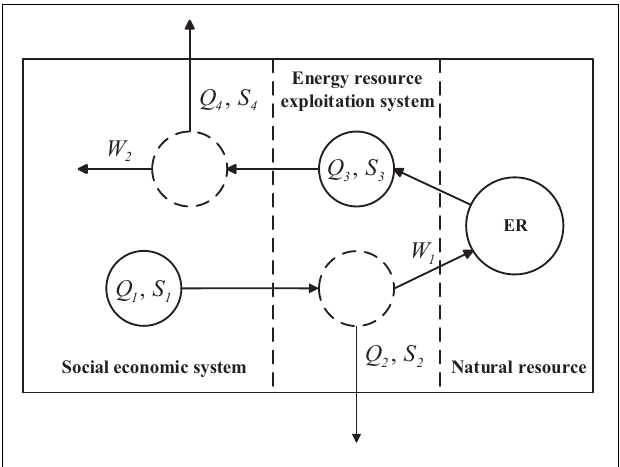
FIGURE 4 | An energy resource exploitation system from an entropy